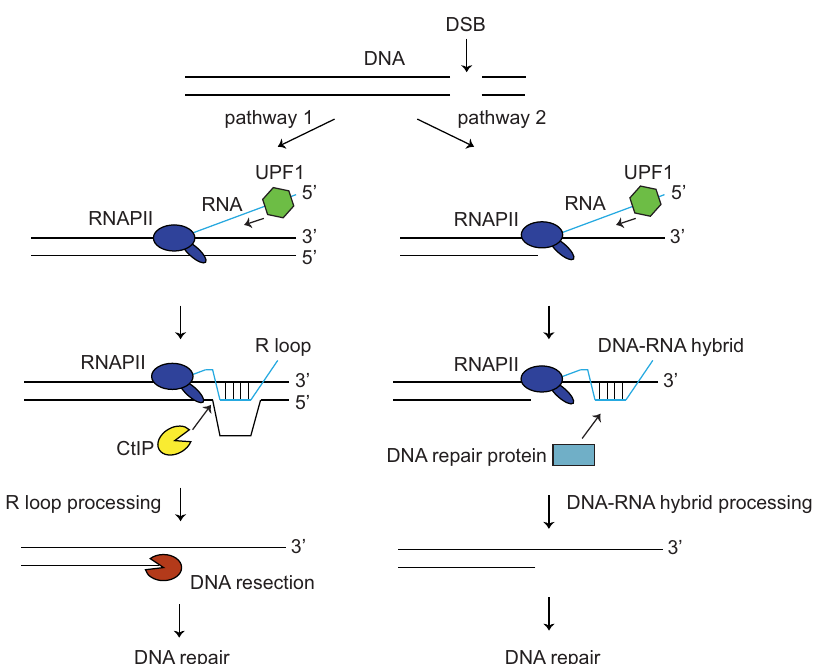
Fig. 7 A model showing how UPF1 drives the formation of R loops and DNA-RNA hybrids to stimulate repair of DSBs. DSBs induce the formation of R loops and DNA-RNA hybrids in two pathways. In pathway 1, UPF1 stimulates the invasion of RNA into dsDNA to form R loops. R loops recruits R loop processing factor CtIP to initiate DNA resection and resection-dependent repair. In pathway 2, UPF1 stimulates the binding of RNA to ssDNA generated by DNA resection to create DNA – RNA hybrids. These structures recruit DNA – RNA hybrid interacting proteins to promote DNA